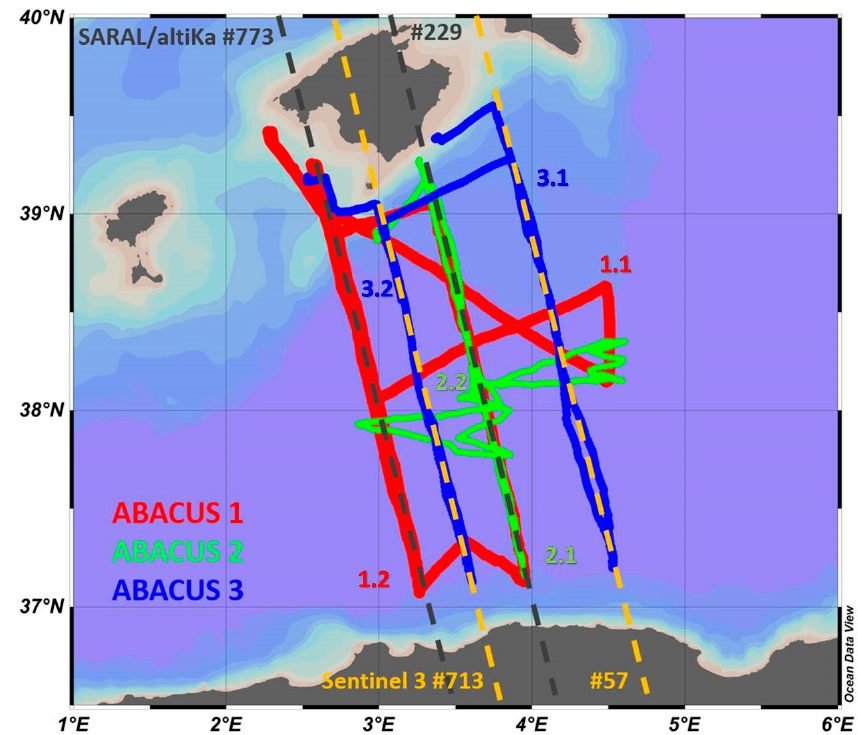
Figure 1. Glider tracks during the missions: ABACUS (Algerian Basin Circulation Unmanned Survey) 1 (red dots), ABACUS 2 (green dots), and ABACUS 3 (blue dots); sub-transects are identified through numbers as in Section 3. The groundtracks of the SARAL / AltiKa (grey dashed lines) and Sentinel 3 (yellow dashed lines) satellites over the study area are also shown. Adapted from Reference [17].